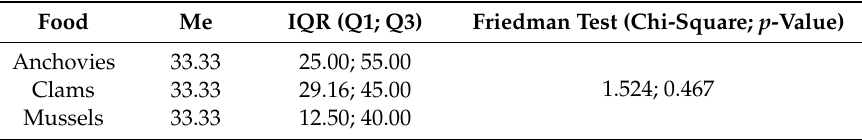
Table 1. First touch during the food preference test